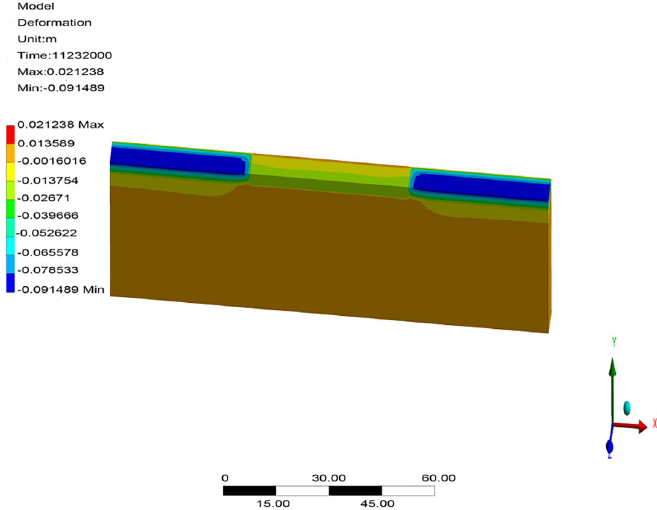
Fig 5. Displacement field after one year of operation in the northeast of China.